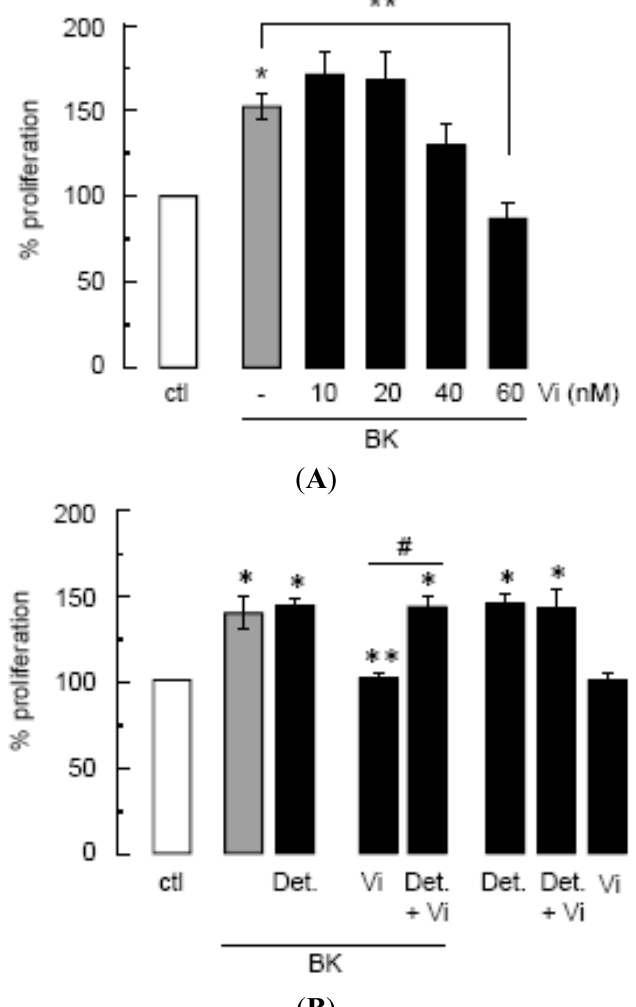
Figure 1. Vasoinhibins block the BK-induced proliferation of BUVEC in a NO-dependent